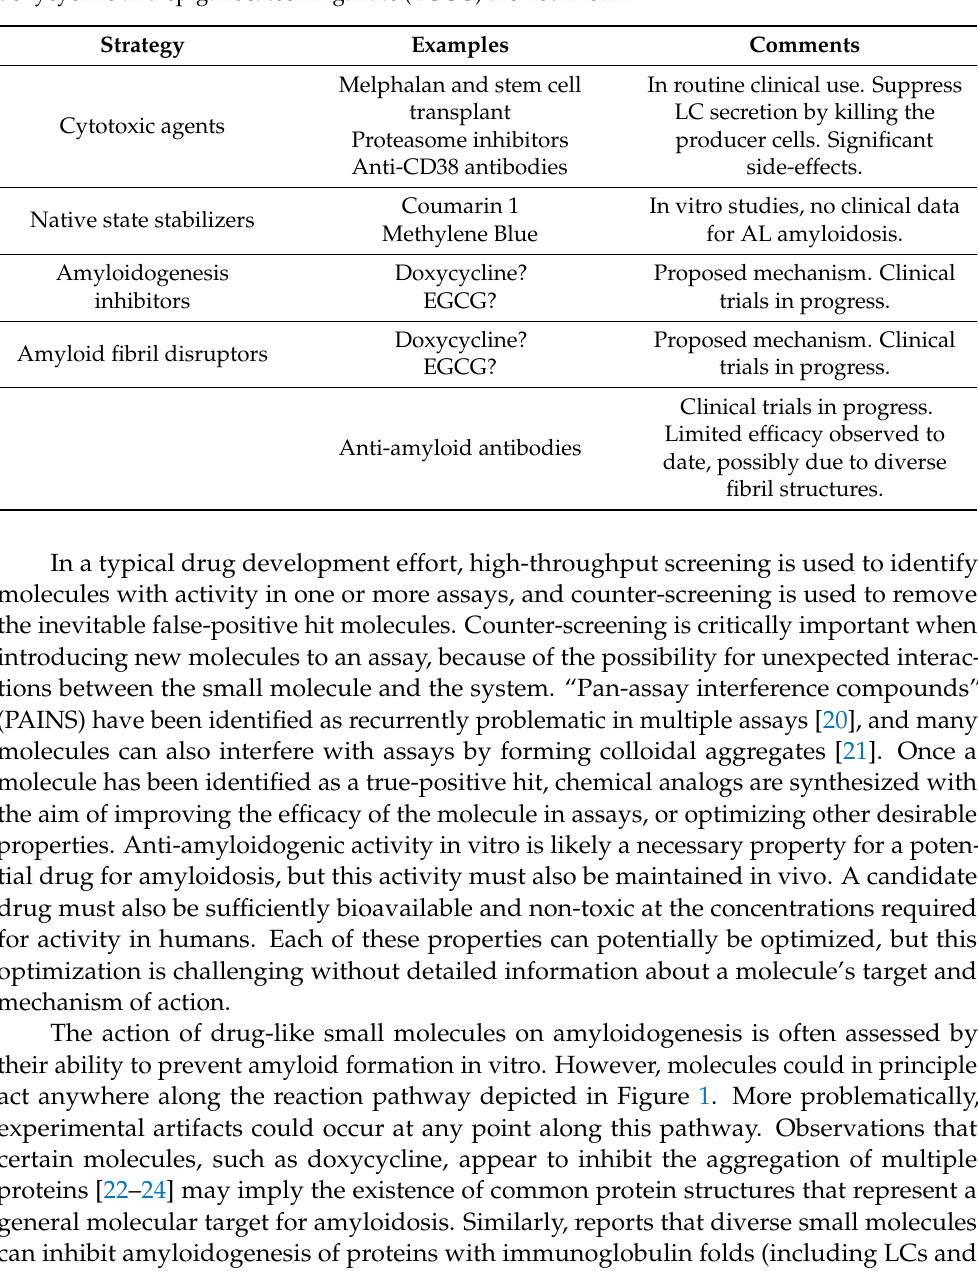
Table 1. Potential strategies to inhibit LC amyloidogenesis. Note that the mechanisms of action of doxycycline and epigallocatechin gallate (EGCG) are not